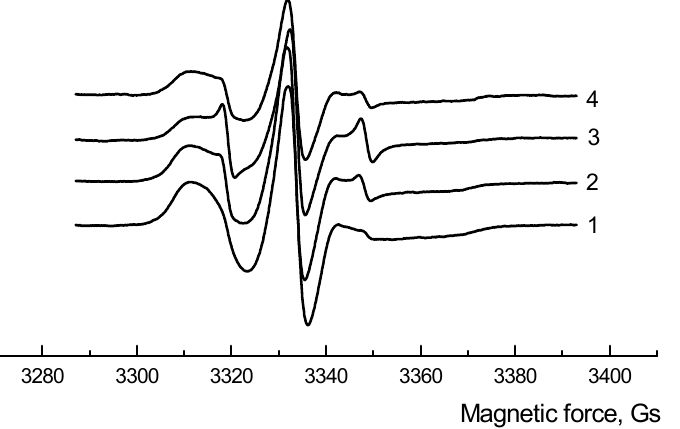
Figure 5. EPR spectra of initial PLA/NR non-woven fibers. The content of NR, wt.%: (1) 0; (2) 5; (3) 10; (4) 15. Table 2. The correlation time of the probe in PLA/NR fibers. The radical was inserted at T = 70 °C. NR, wt.%